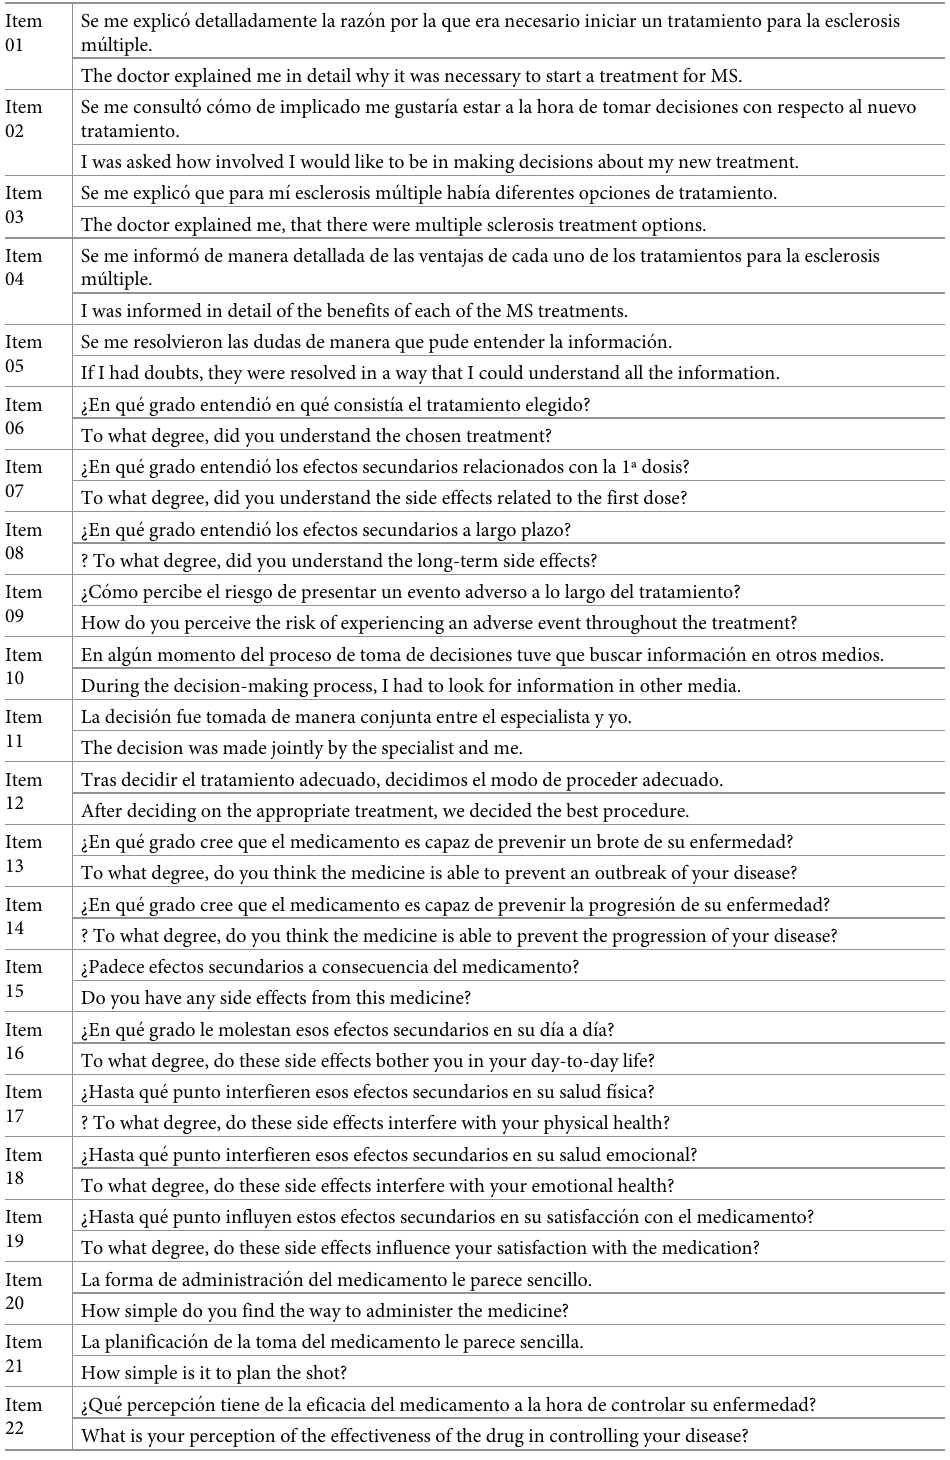
Table 1. Questionnaire